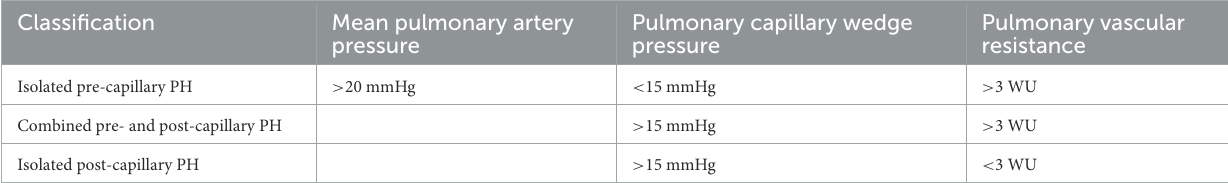
TABLE 2 The 6th world symposium defined three hemodynamic profiles of pulmonary hypertension (14).